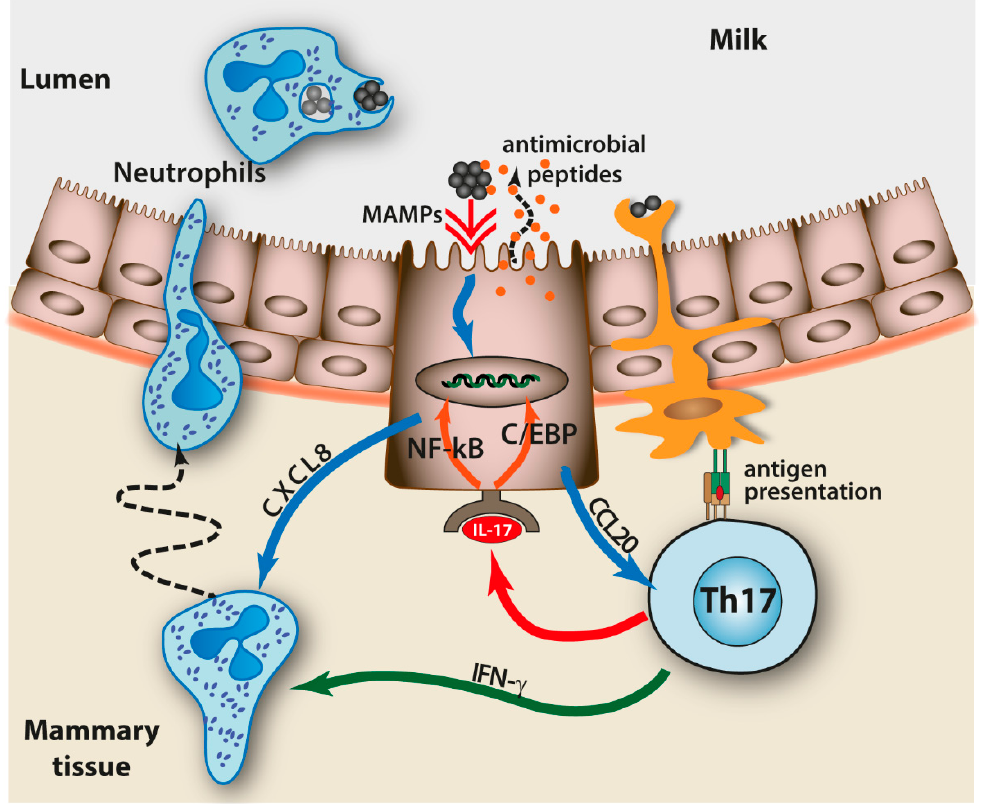
Figure 2. Mobilization of innate immune effectors by type 3 adaptive immunity in the bilayer epithelium of cisterns and large ducts. The capture of bacterial antigens and presentation by intra- epithelial antigen-presenting cells to local Th17 lymphocytes induces the production of IL-17 that activates mammary epithelial cells. In turn, these cells react to bacterial MAMPs and IL-17 by producing antimicrobial peptides at the luminal side and chemokines, such as CXCL8 and CCL20, at the basal side that attract neutrophils and other lymphocytes. The neutrophils, activated by the chemokines and IFN- γ , traverse the epithelium and reach the lumen where they can phagocytose invading bacteria.